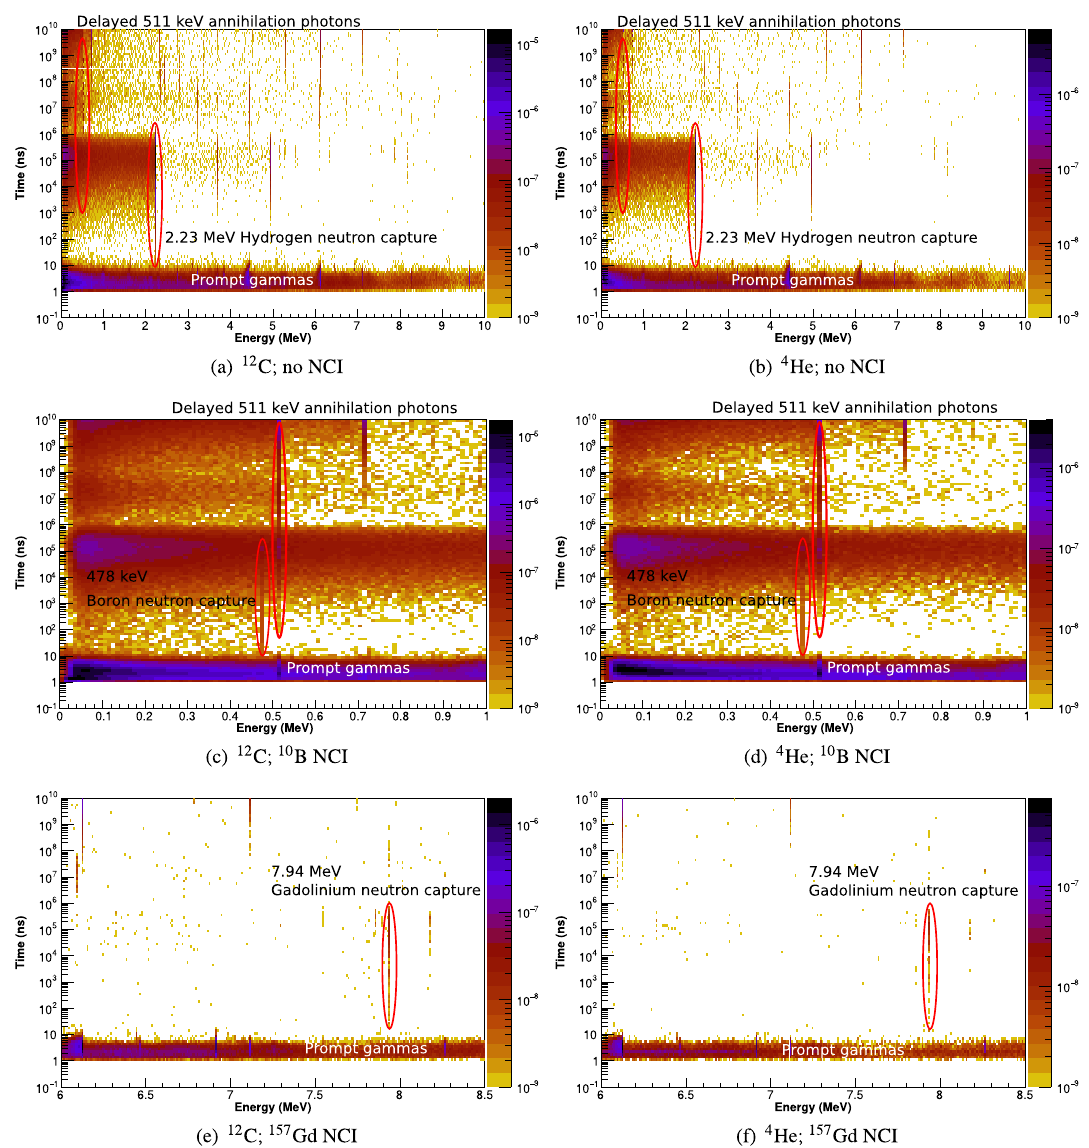
Figure 5. The energy/arrival-time spectrograms of photons entering the detector following an instantaneous irradiation by polyenergetic carbon and helium ion 1000 linearly spaced energy bins (each 10 keV in width, from 0 to 10 MeV), and 100 logarithmically spaced arrival time bins (from 0.1 to 10 10 ns). Arriving neutrons are distributed into 130 logarithmically spaced energy bins (from 10 − 10 to 10 3 MeV), and 100 logarithmically spaced arrival time bins (from 0.1 to 10 10 ns). Again, time is measured relative to the instant at which the primary particle is generated. From the energy and timing distribution of the neutrons entering the NCI region (Fig. 4), it is apparent that arrival time of the neutrons depends on the energy of the neutron. Neutrons which are created with high initial kinetic energies must scatter multiple times to reach thermal equillibrium, which takes time. The neutron spectrograms for both carbon and helium ion beams exhibit similar characteristics, with thermal neutrons reaching the NCI region between ∼ 12 and 10 6 ns after creation. As a result of the delay between primary particle arrival and thermal neutron arrival time in the NCI region, it is expected that gamma emissions due to the thermal neutron capture process within the NCI will start to be observed between 12 and 10 6 ns after the onset of a beam pulse.